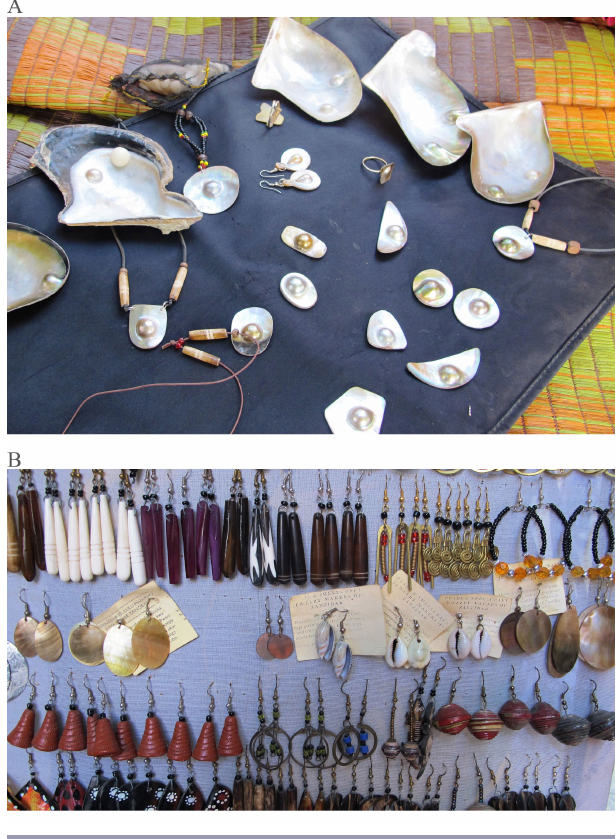
Fig. 2 . (A) Jewelry produced using farmed pearls ( mabe in Kiswahili); (B) jewelry produced using collected sea shells (the earrings with a price tag) by local women in South Zanzibar, Tanzania.